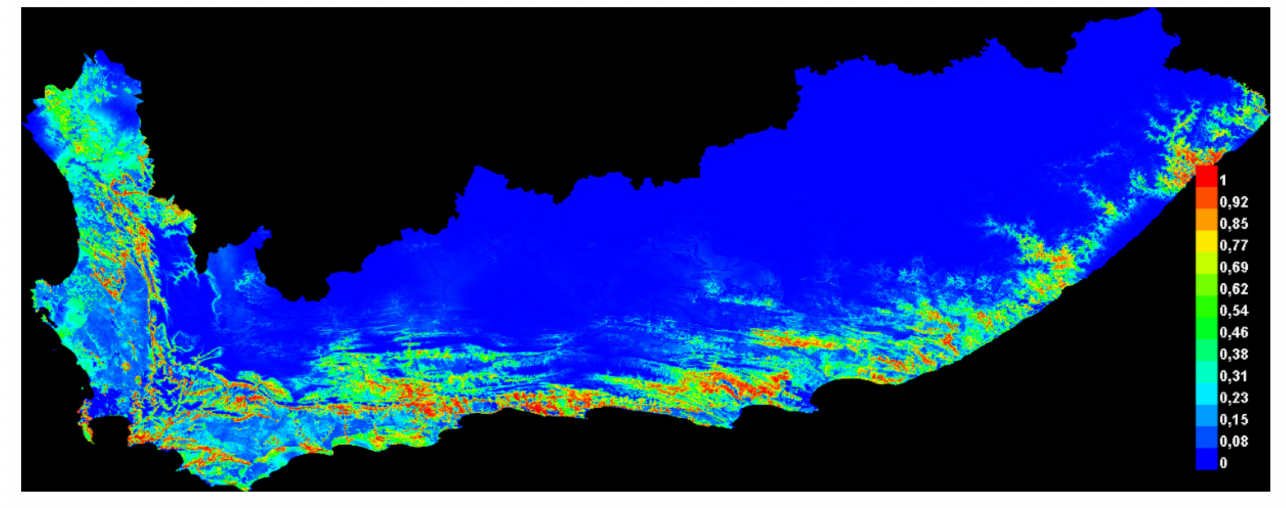
Figure A3. Predicted distribution of potential prey species for leopard from low presence (0) to high presence